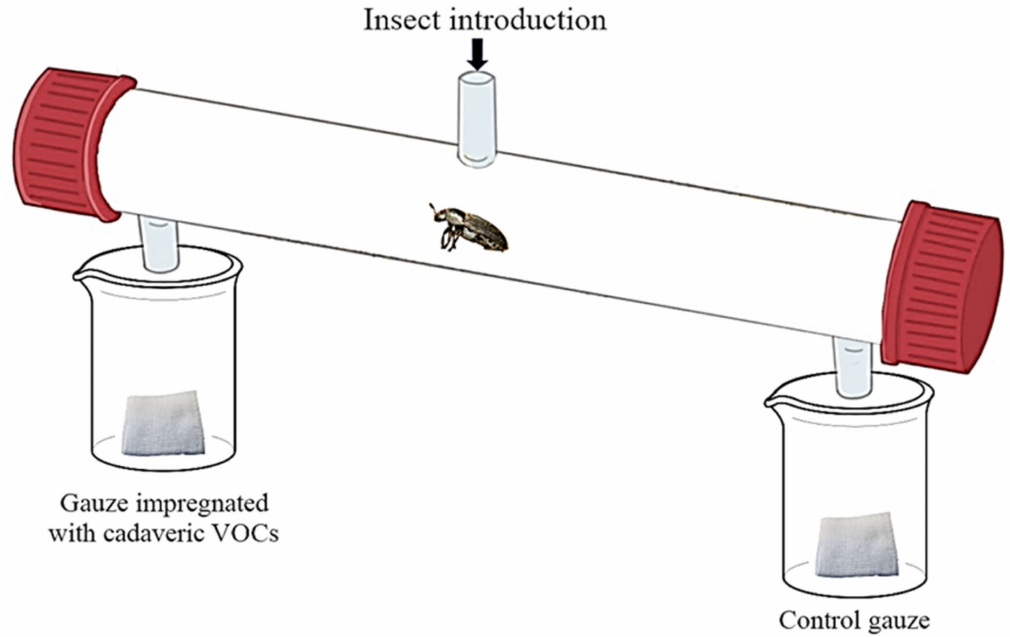
Figure 1. The dual choice olfactometer used to assess the preferences of Dermestes frischii for the volatile cues associated with each decomposition